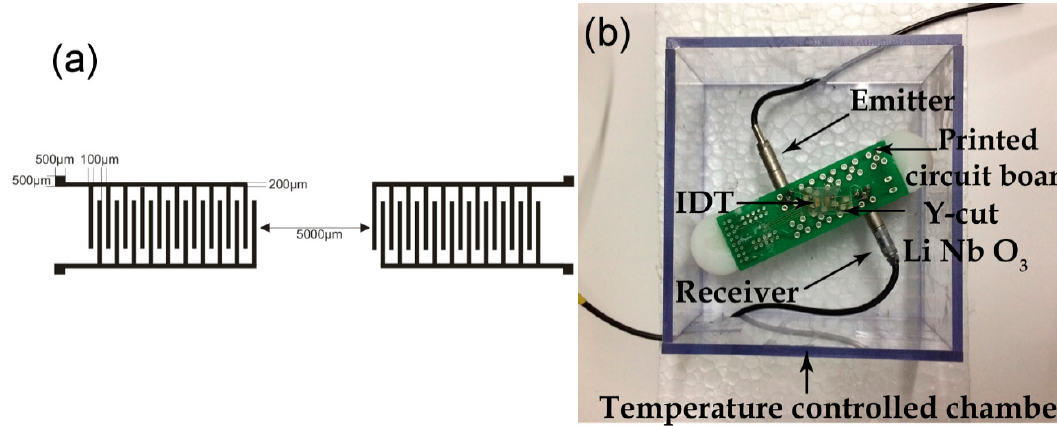
Figure 1. ( a ) Schematic representation of the fabricated interdigital transducers (IDT) marked with all the dimensions and, ( b ) Experimental setup of the fabricated IDT is a temperature-controlled chamber for excitation and detection of S surface acoustic waves (SAWs) and longitudinal waves.